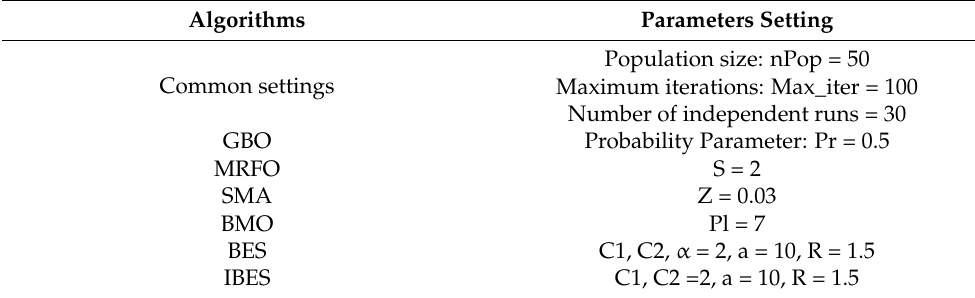
Table 1. Parameter settings of the selected techniques.